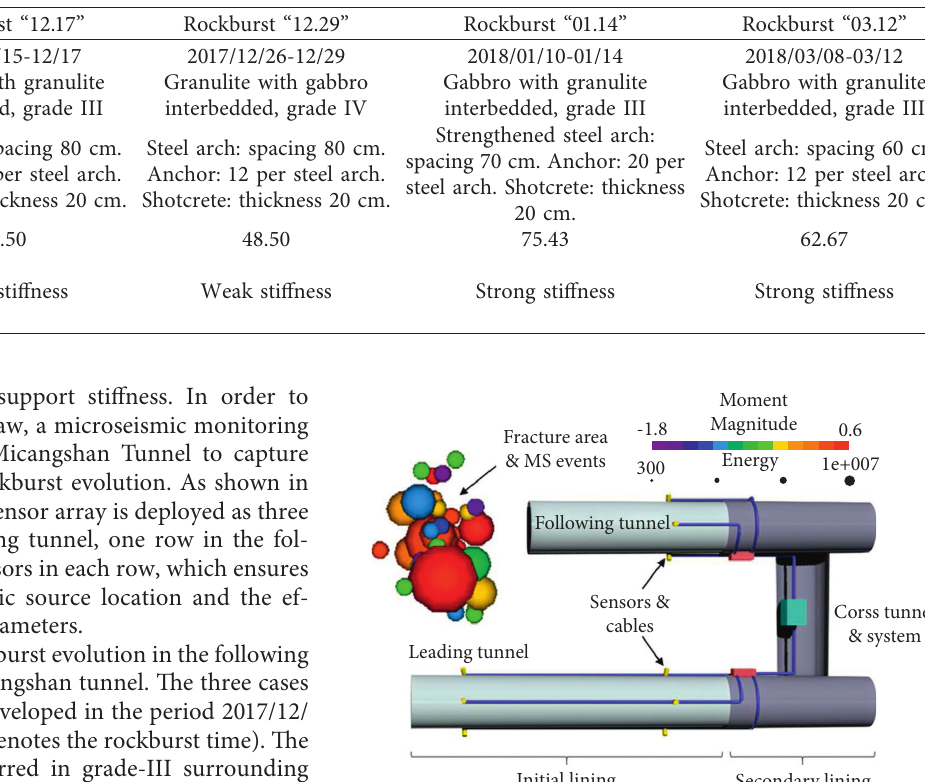
Table 2: Composite stiffness of surrounding rock and support system in rockburst.